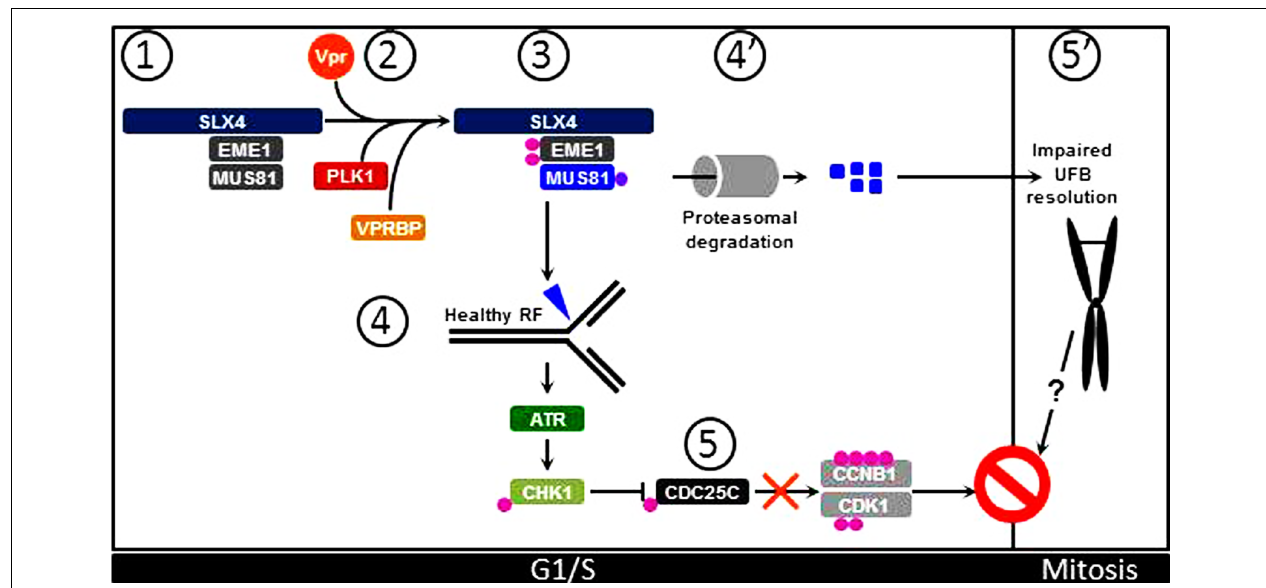
signaling pathway and subsequent activation of CHK1. Activated CHK1 provokes inhibitory phosphorylation of CDC25C, leading to inhibition of CCNB1:CDK1 and cell cycle arrest at the G2/M transition. (4 (cid:2) ) In addition, ubiquitinated MUS81 molecules are degraded by the proteasome machinery, leading to decreased steady-state levels of MUS81. (5 (cid:2) ) Consequently, UFBs are not processed and persist in Mitosis.This possibly contributes to overall G2/M arrest inVpr expressing